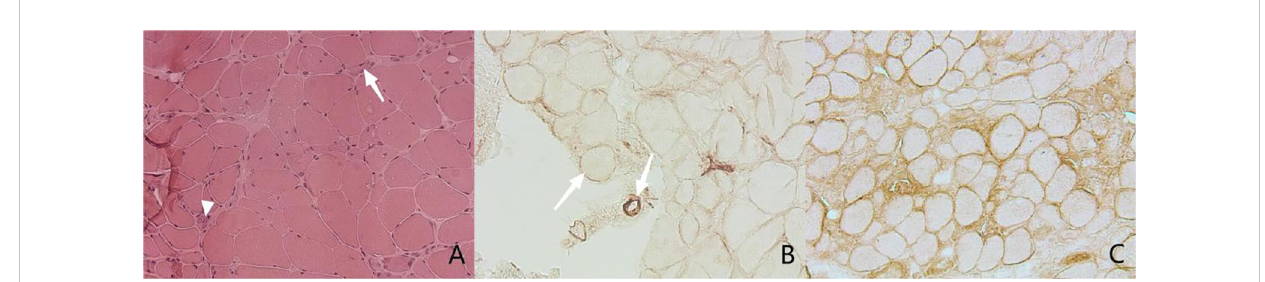
FIGURE 1 Muscle pathology. (A) Hematoxylin and Eosin staining (H&E), original magni fifi cation x200. The image shows necrotic fi bers (arrow) and the regenerated muscle fi bers (arrow head). (B, C) Immnunochemical staining, original magni fifi cation x200. (B) shows MAC deposition in sarcolemma of non-necrotic fi ber (arrow) and endomysial capillaries (arrow head), While (C) indicates diffused expression of MHC class I in sarcolemma of necrotic fi